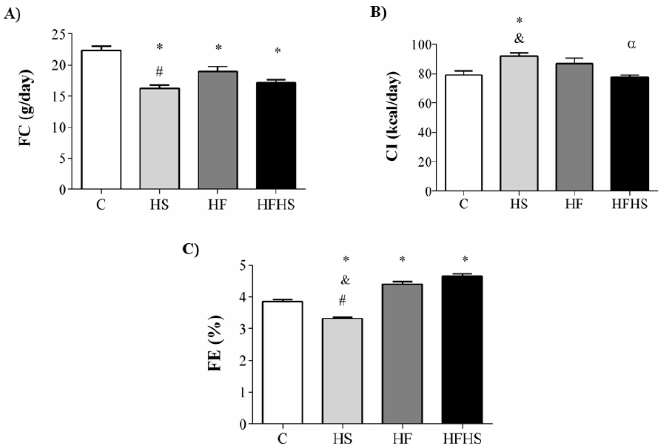
Figure 4. Nutritional profile of rats fed either the control diet (C; n = 12), high-sugar diet (HS; n = 14), high-fat diet (HF; n = 13), or high-fat and high-sugar diet (HFHS; n = 13). ( A ) FC = food consumption; ( B ) CI: caloric intake; ( C ) FE: feed efficiency. Data are presented as the mean ± SEM. One-way ANOVA for independent samples followed by Tukey post hoc test. p < 0.05 vs. * C; # HF vs. HS; & HFHS vs. HS; α HF vs. HFHS.